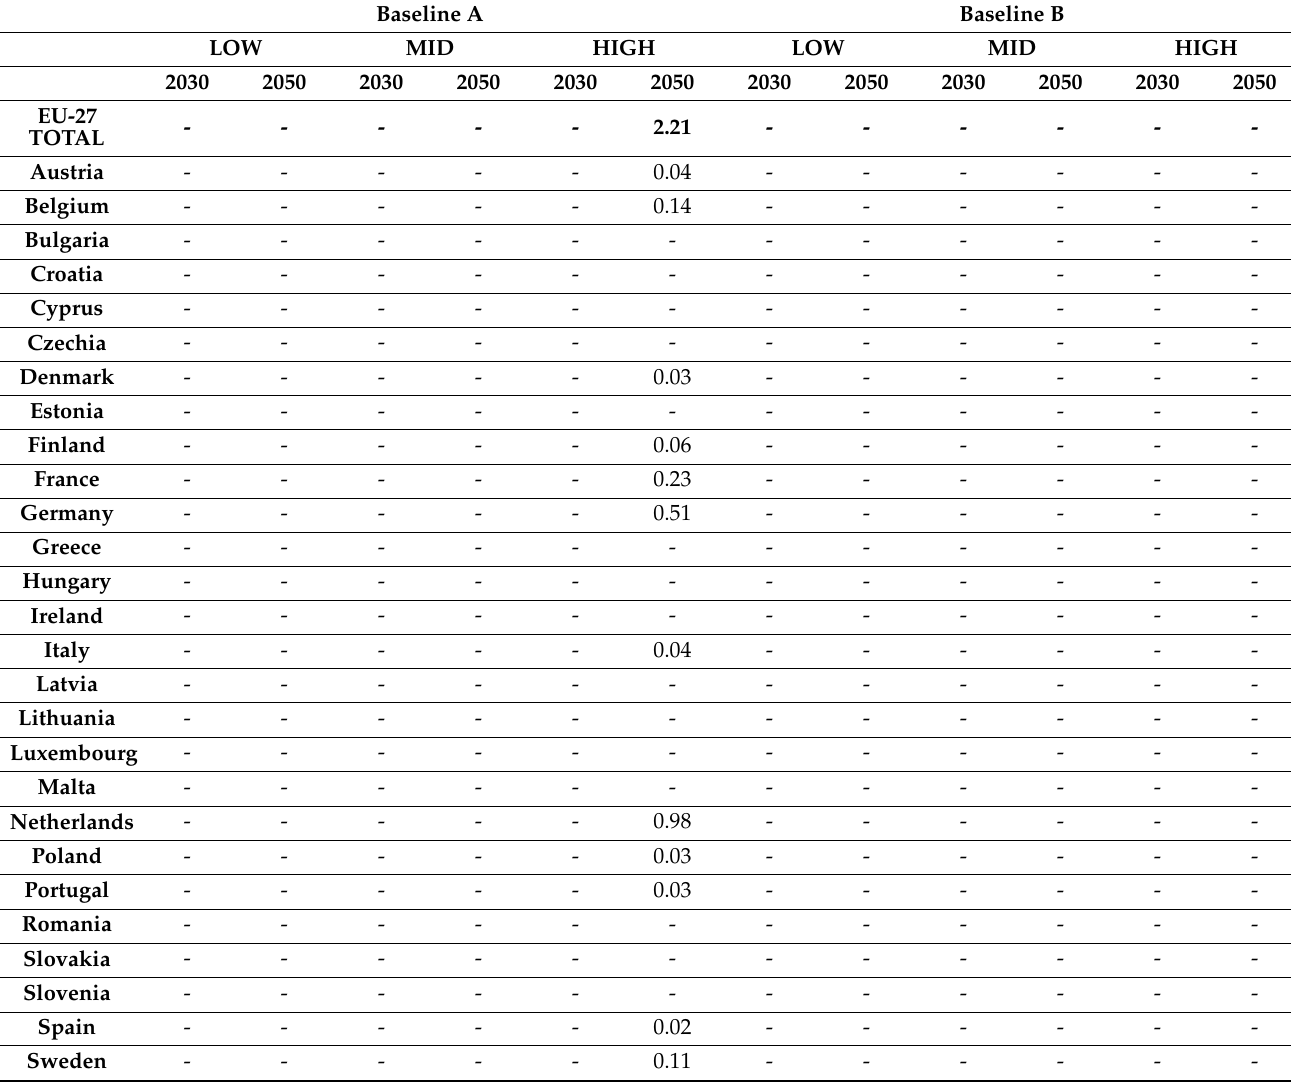
Table A4. LCAF technical potential at Member State level (Mtoe). Calculated using output volume-based allocation